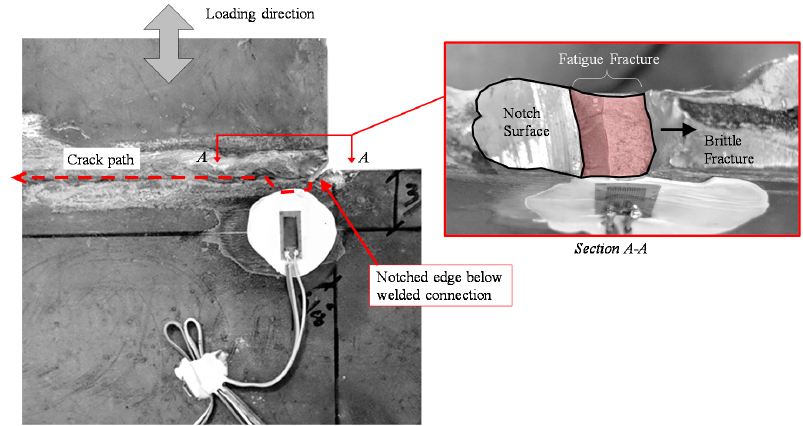
Figure 34. Fatigue crack growth and eventual brittle fracture of specimen C3-3 following 989,235 cycles.